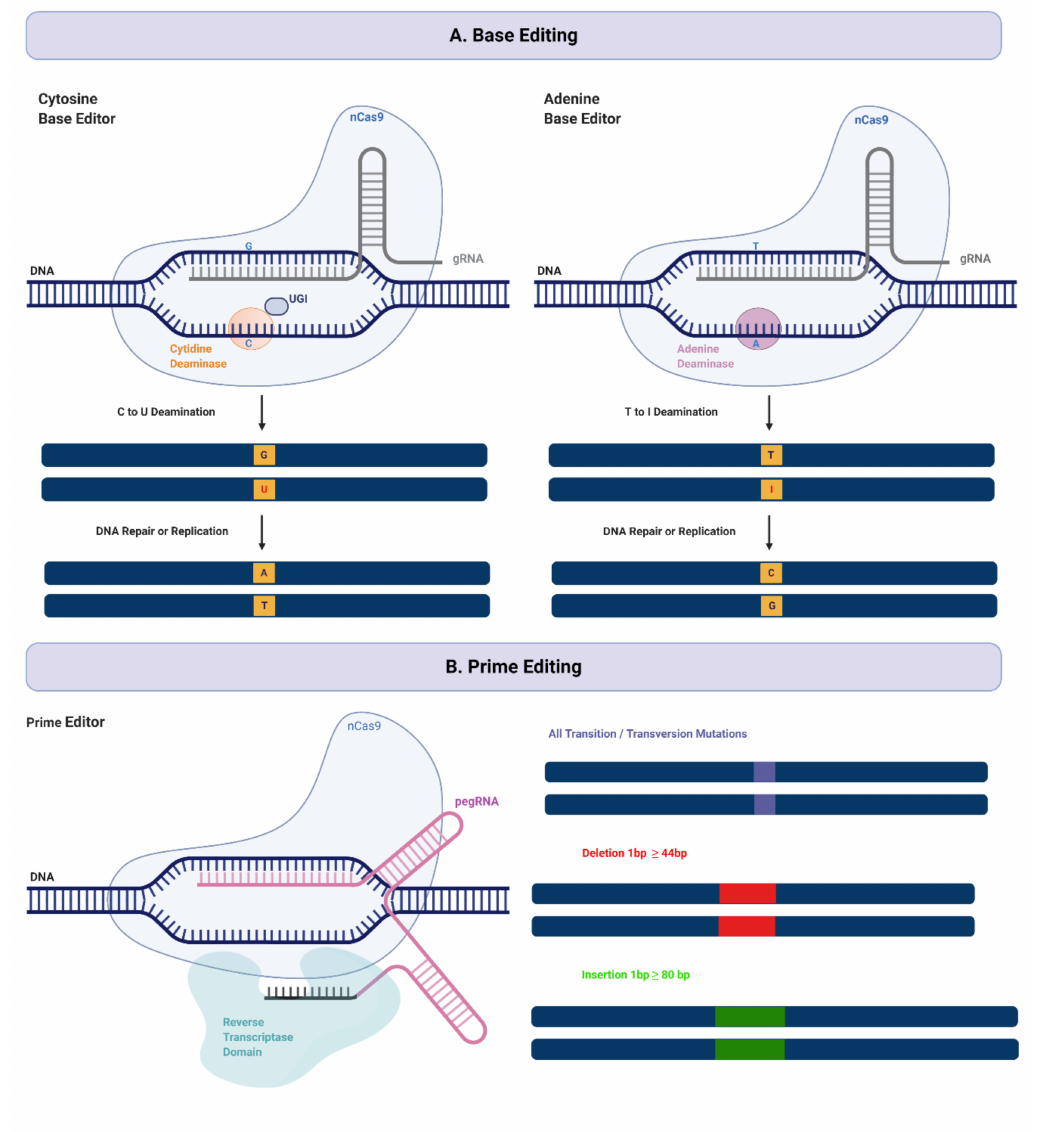
Figure 1. CRISPR DNA Base-Editing Tools. ( A ) DNA Base-editing. DNA base-editors encompass two key components: a Cas enzyme for programmable DNA binding and a single-stranded DNA modifying enzyme for targeted nucleotide alteration. Two classes of DNA base-editors have been described: cytosine base-editors and adenine base-editors. Cytosine deamination generates uracil, which base pairs as thymidine in DNA. Fusion of uracil DNA glycosylase inhibitor (UGI) inhibits the activity of uracil N-glycosylate (UNG), thus increasing the editing e ffi ciency of cytosine base-editing in human cells. Adenosine deamination generates inosine, which has the same base pairing preferences as a guanosine in DNA. Collectively, cytosine and adenine base-editing can install all four transition mutations (C → T, T → C, A → G, and G → A). ( B ) Prime-editing. Prime-editors use an engineered reverse transcriptase fused to Cas9 nickase and a prime-editing guide RNA (pegRNA). The pegRNA contains the sequence complimentary to the target sites that directs nCas9 to its target sequence as well as an additional sequence spelling the desired sequence changes. Prime-editors expand the scope of DNA editing to not all transition and transversion mutations, as well as small insertion and deletion